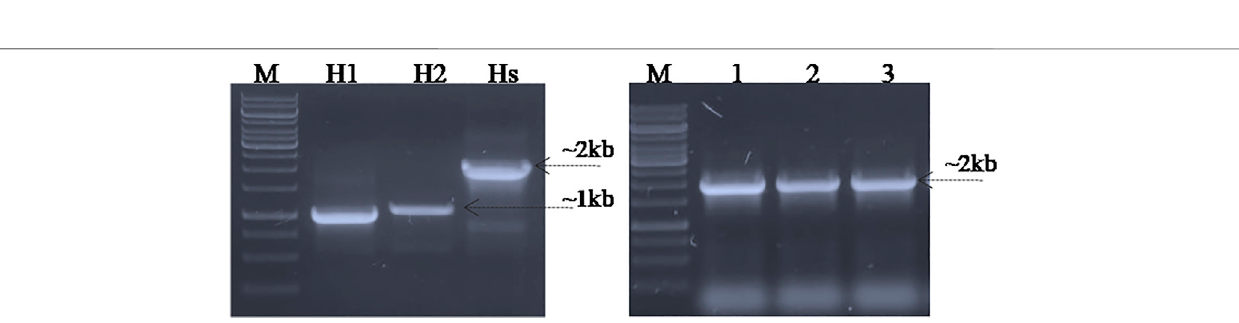
FIGURE 3 | PCR ampli fi cation and cloning of homologous arms in the pET22b (+) vector. Lane H1; homologous arm1, Lane H2; homologous arm 2, Lane Hs; fusedhomologousarms,LaneP;PCRampli fi edfusedhomologousarmswasusedaspositivecontrol,Lane1 – 3;ColonyPCRofTop10cellscarryingfusedhomologous arms as the DNA editing template cloned in the pET22b (+) vector